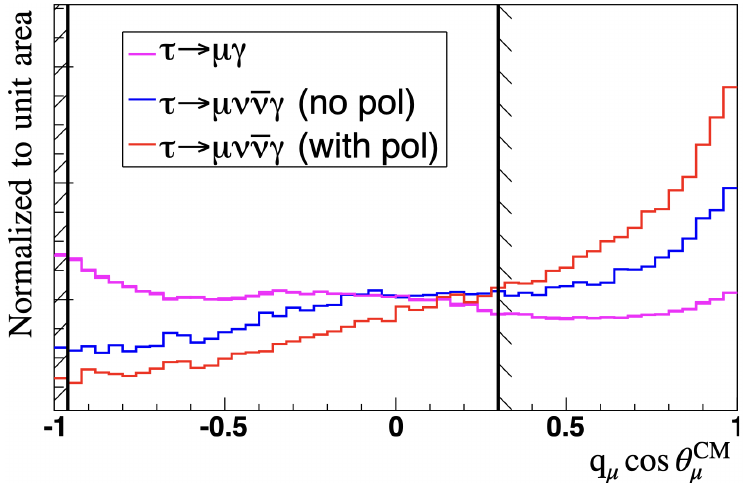
Figure 7. Distribution of the cosine of the signal-side muon multiplied by the muon charge for signal and background events with and without electron beam polarization in the τ − → µ − γ search analysis [112].